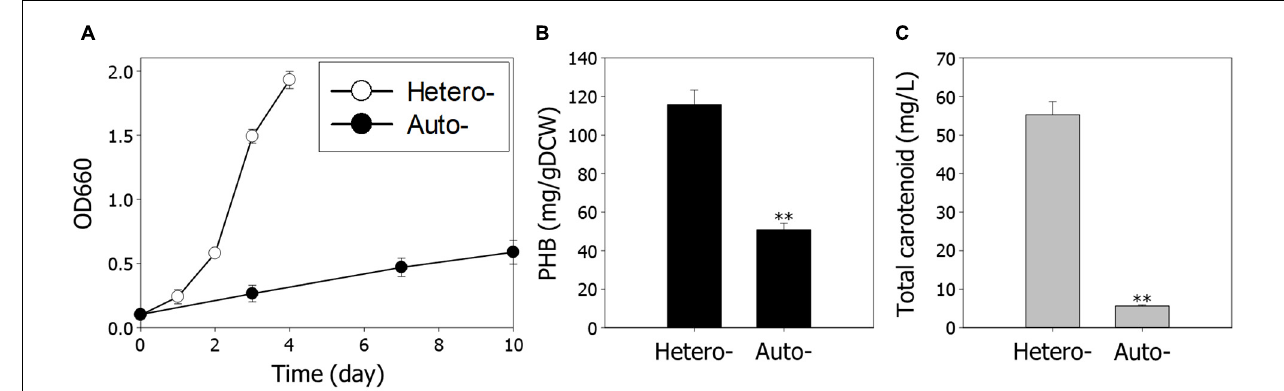
FIGURE 1 | Comparison of cell growth and metabolite production under hetero- and autotrophic conditions in Rhodobacter sphaeroides . (A) Cell growth under hetero- and autotrophic conditions. The cells were cultivated with different carbon sources, succinic acid, and CO 2 , respectively. (B) Contents of PHB. (C) Concentrations of total carotenoids. Experiments were conducted in triplicate and error bars indicate standard deviation of mean. Asterisk represents statistically significant difference, as determined by a Student t -test ( ∗∗ P <